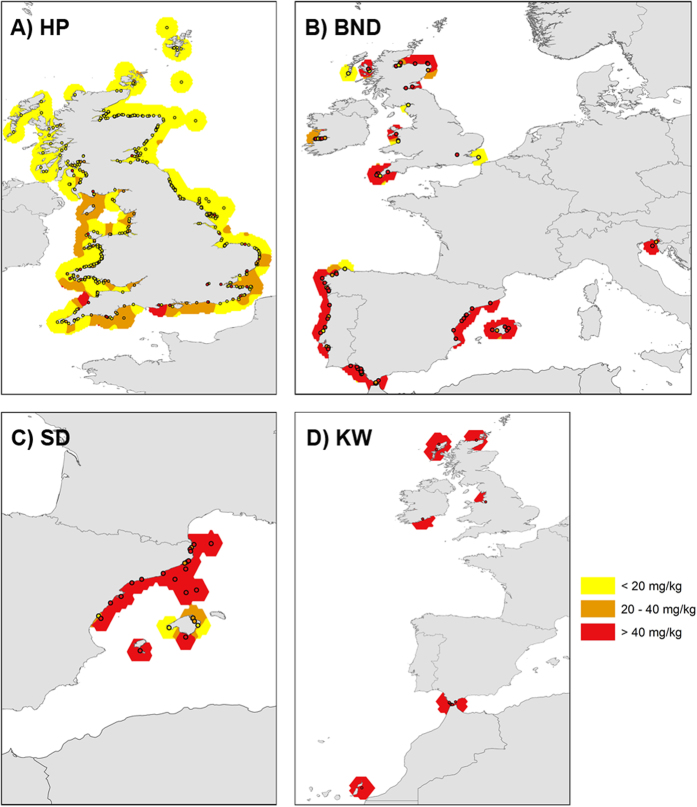
(A–D) Distribution map (smooth mean density kernel plots) of ∑PCBs data points in Europe – all cetacean species (all ages) from 1996–2012. (A) – HPs (n = 548); (B) – BNDs (n = 110); (C) – SDs (n = 71) and (D) – KWs (n = 21). Spatial distribution of ∑PCB lipid concentrations produced in Esri ArcMap 10.1 (www.esri.com). Maps are displayed in the WGS84 co-ordinate system. Data points are shown along with local averages. These averages were calculated by kernel smoothing using a polynomial order 5 kernel with power = 0, ridge parameter = 50 and bandwidth based on the spatial distribution of the observations for each species: bottlenose dolphin 0.75 degrees; harbour porpoise 0.5 degrees; killer whale 1.2 degrees; striped dolphin 0.5 degrees. Both the data points and the local averages are displayed in three colours: yellow (∑PCB concentration =  < 20 mg/kg); orange (∑PCB concentration = 20–40 mg/kg lw); and red (∑PCB concentration =  > 40 mg/kg lw).